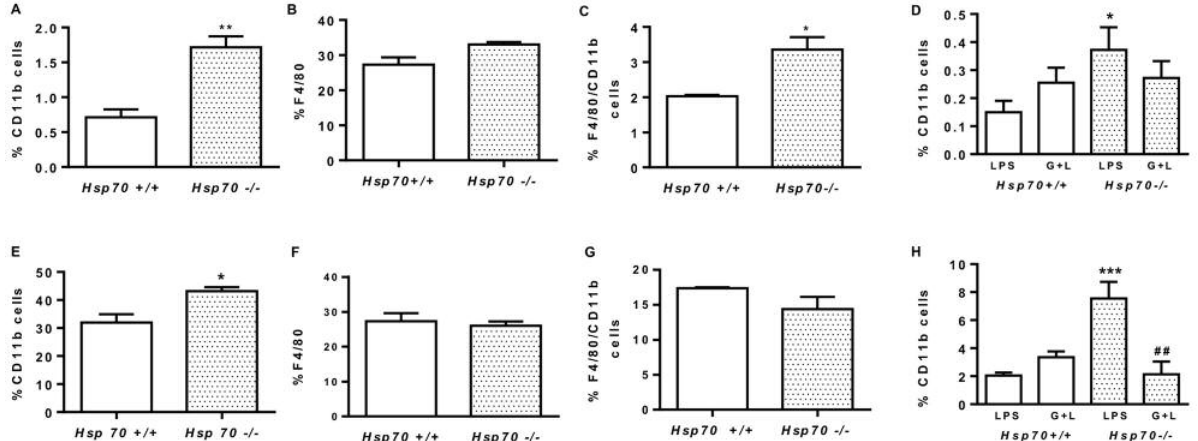
Figure 4. Flow cytometry of spleen and bone marrow of Hsp70+/+ and Hsp70-/- mice. Flow cytometry analysis was performed and F4/80 and CD11b were used as the sole surface markers for identifying macrophages. Basal levels of percentage (%) CD11b, F4/80 and F4/80/CD11b of spleen cells (A-C) and bone marrow cells are shown, respectively (E-G). Mice also received, i.p. GLN (0.75 mg kg -1 ) or normal saline and one hour later LPS (150 μ g) and the percentage of CD11b cells was measured in spleen (D) and bone marrow (H). Means ± SEM. Asterisks (*) depict statistical di ff erence between genotypes exposed to the same treatment. *, p < 0.05; **, p < 0.001; ***, p < 0.0001. Hash signs (#) depict statistical di ff erence between treatments on the same genotype. #, p < 0.05; ##, p < 0.001. Each graph shows a representative experiment of at least three independent experiments.